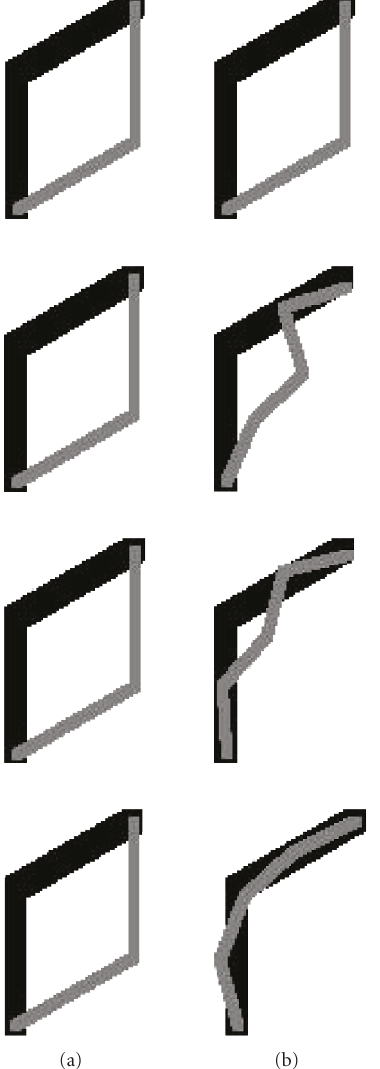
Figure 7: Experiment 2. Initial (gray) and objective (black) configuration with the same end e ff ector position. Left column, sequence applying inverse kinematics without image constraint. Right column, sequence applying inverse kinematics with image constraint.